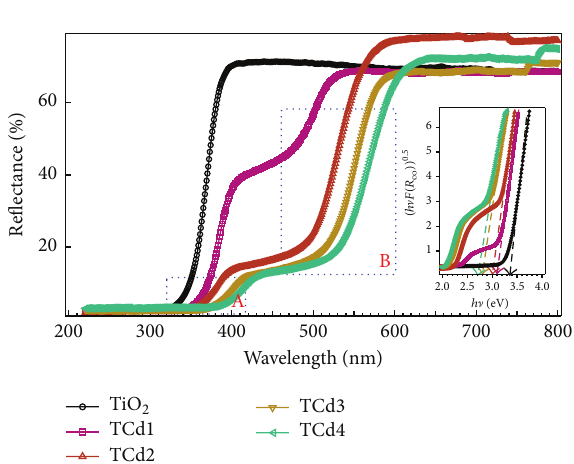
Figure 6: Room temperature UV-Visible diffuse reflectance spectra of the parent TiO 2 and the TCd 𝑋 ( 𝑋 = 1 to 4) nanocomposite photocatalyst. Inset is the Tauc plots of (ℎ ] 𝐹(𝑅 ∞ )) 0.5 versus ℎ ] showing the band gaps of the titania core and the core-shell